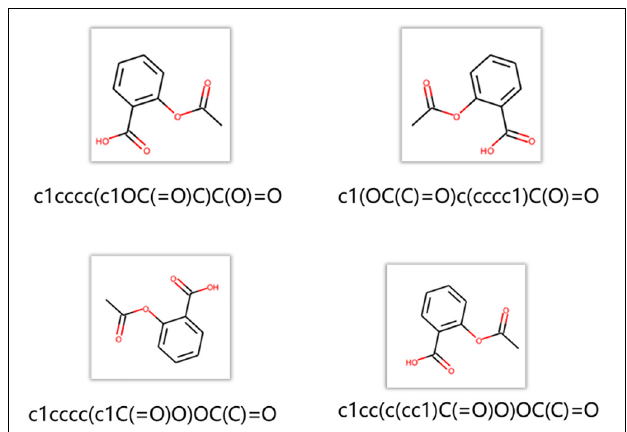
FIGURE 5 | Generation of different SMILES strings for the same molecule.